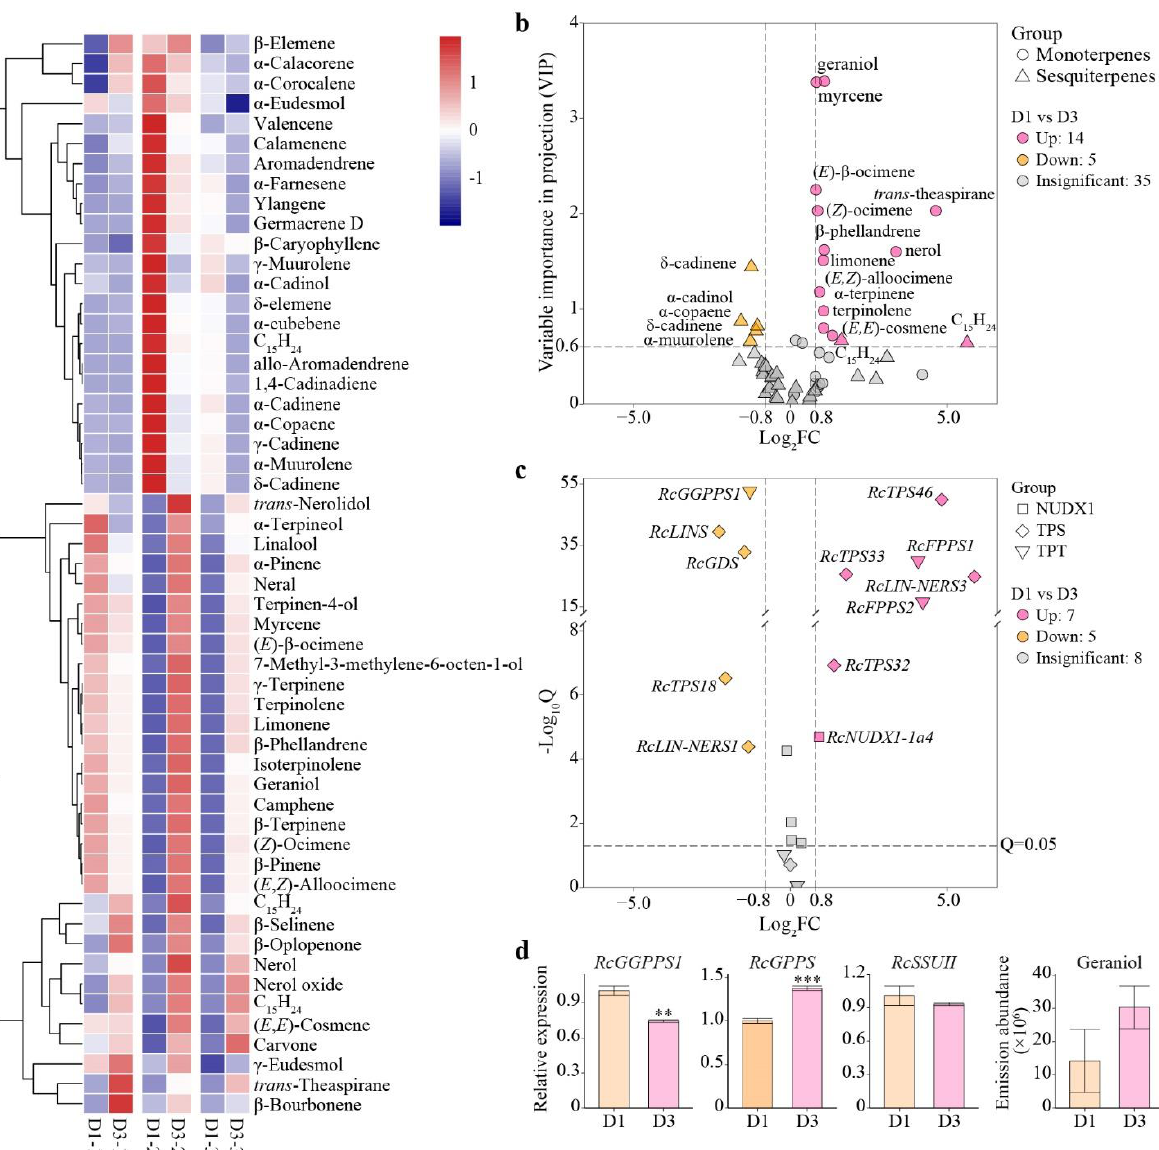
Figure 6. Differential metabolites and genes involved in middle and downstream pathway of volatile terpene biosynthesis in different samples. ( a ) Heatmap of volatile terpenes in D3 and D1 samples. Clustering_distance_rows ‘ euclidean ’ , clustering_method ‘ complete ’ . ( b ) Volcano plot of differential volatile terpenes between D1 and D3 samples. ( c ) Volcano plot of differential terpene-related genes between D1 and D3samples. ( d ) Emission abundance of geraniol and expression levels of three RcTPTs in D1 and D3 samples. RhUBI2 was used as an internal control. Data are presented as the mean ± standard error ( n = 3). Asterisks indicate significant differences between D1 and D3 samples at ** p < 0.01; *** p < 0.001 by Student ’ s t-test.